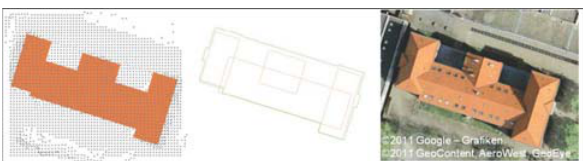
Figure 7. Building parts with lower roofs and smaller extrusions have not been reconstructed: footprint in point cloud (left), compaison with given ground plan (middle), and an aerial image as reference (right) High resolution data, relatively speaking, is able to provide higher accuracy and represent small structures more meaningfully. As shown in Figure 8, superstructure, in this case a chimney (black), has been extracted from a point cloud with the density of about 0.18 meter. A more detailed footprint (blue) is reconstructed including the chimney shaft. Without ground truth data, the result is projected (red contour) into the raster image (right) of the data for comparison. Please note the lighter margin outside the red contour approximately indicates the protrusion of the roof, which has been recognized as the ground points below are also